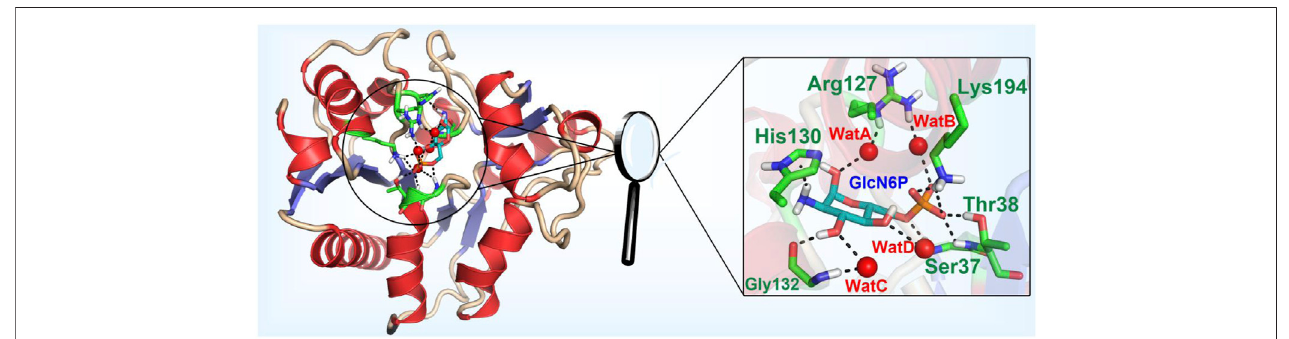
FIGURE 3 | Mode of binding of GlcN6P in the active site of Smu NagB.